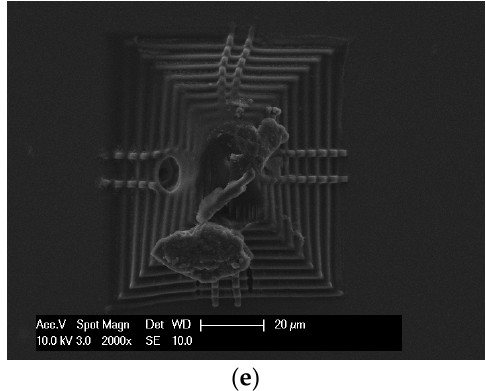
Figure 3. SEM images of 2D and 3D fabricated structures using Formulations 2 and 5. ( a , b ) show the results of fabricating increasingly more complex structures with Formulation 2 (Table 1); ( c – e ) show the results of fabricating increasingly more complex structures with Formulation 5.